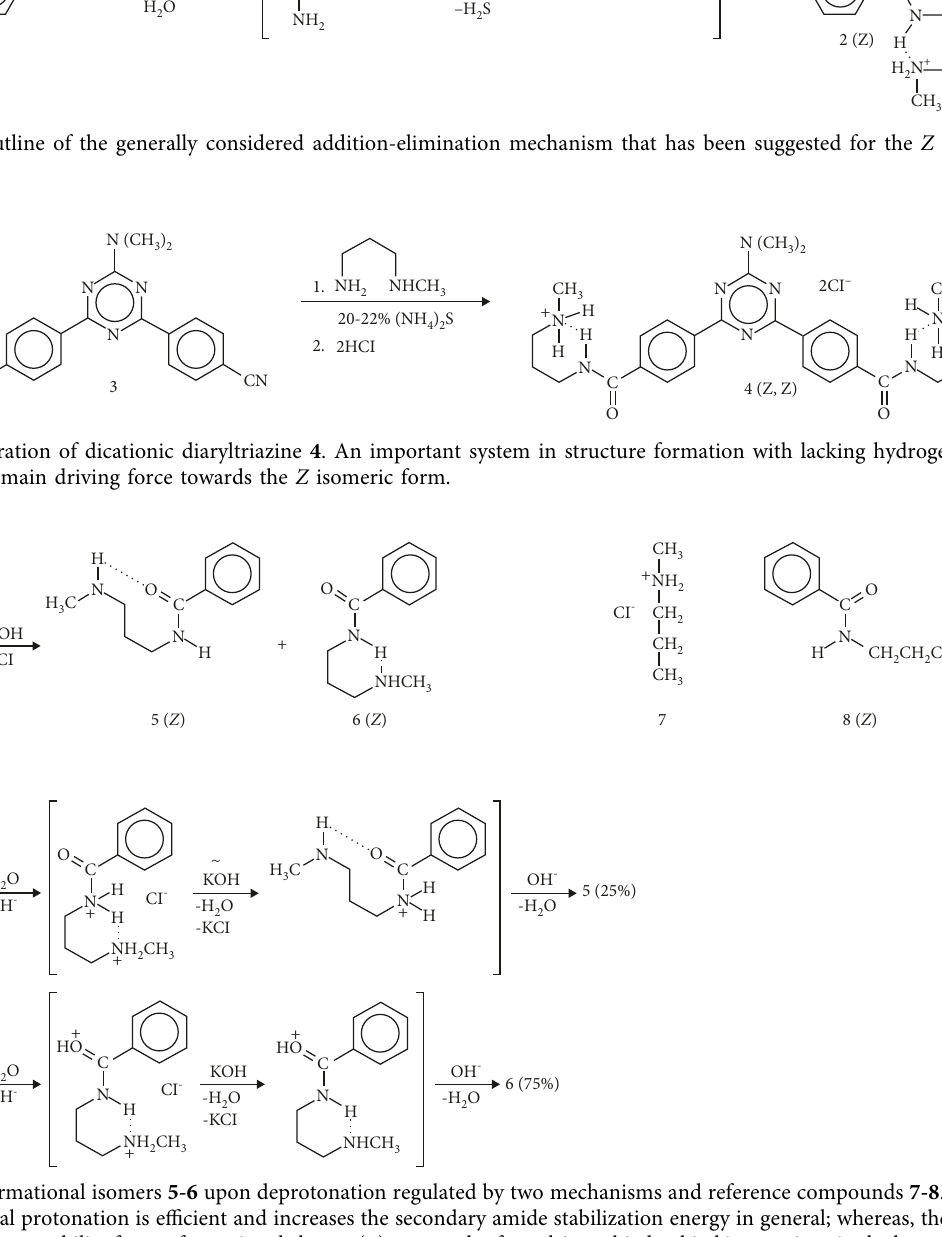
infrared spectra. Characteristic chemical shifts ( δ H and δ C ) data presented here support the idea about the existence of and wavenumbers ( ] max ) are embedded in the Experimental two different types of interactions, stabilizing conformational states in the deprotonated products. The negative polarized Section. The absence of the intramolecular N ... H + ... N hy- group CONH can act as either a hydrogen-bond donor or drogen bonds (H + -bonding) strongly modifies the spectra of acceptor. Intramolecular, nitrogen-to-oxygen migration from secondary amides 2 and 4-6 , causing changes in the NMR carbamoyl NH to carbamoyl CO allows the transfer of the signals (quintet multiplicity, no characteristic six-proton polymethylene-bridged methylamino group in the secondary sharp singlet). Comparison between 5 (CH 3 N H ... O CNH) − (cid:30) amide moiety to afford 5 . and 6 (CON H ... NHCH 3 ) has been made (Figure 1). The −